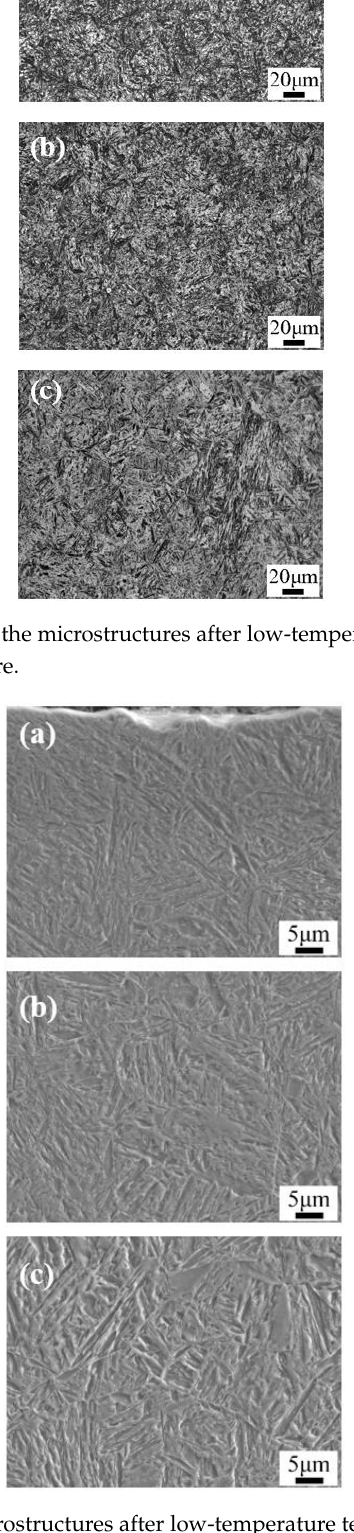
Figure 6. SEM images of the microstructures after low-temperature tempering: ( a ) the surface; ( b ) the subsurface; and ( c ) the core. The carbon content distribution and the hardness gradient of the carburized layer of the 18Cr2Ni4WA steel after quenching are shown in Figure 7. According to the Chinese national standard GB / T 9450-2005 [17], the hardened layer produced by carburizing and quenching was defined as the vertical distance from the surface to a depth with a Vickers hardness of 550 HV. Therefore, the depth of the carburized layer after carburizing was 1.35 mm, which corresponds to 96% of the pre-set carburized layer depth. After quenching, the surface of the carburized layer had a 0.67% carbon content. The measurements of the carburized layer were consistent with the pre-set values. Vacuum low-pressure carburization resulted in a good carbon content distribution in the carburized layer. The carbon content of the carburized layer decreased gradually and evenly, resulting in a uniform hardness gradient of the carburized layer. The hardness gradient curve shows that the carbon content gradually decreased with increasing depths in the carburized layer and the high-carbon acicular martensite in the surface layer was